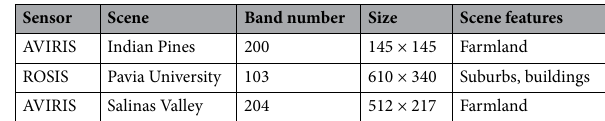
Table 1. Basic information of experimental hyperspectral data.